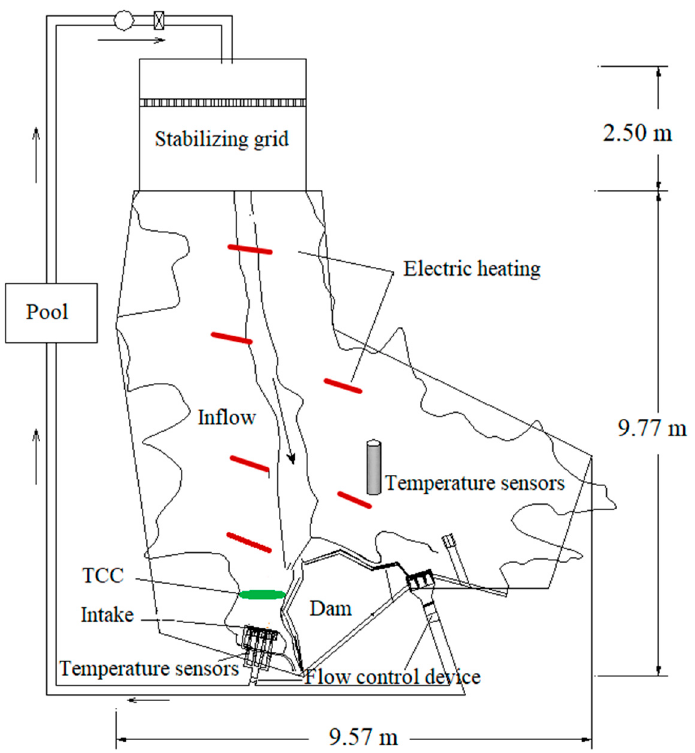
Figure 5. Laboratory test geometry and heating system layout.